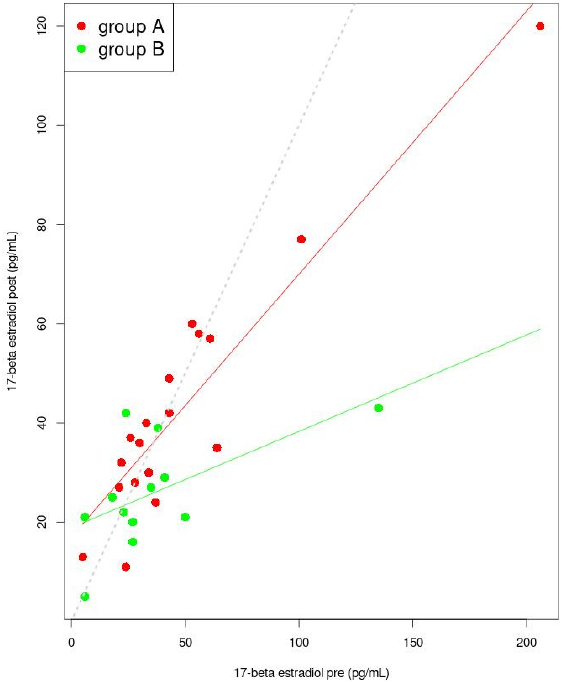
Figure 6. Linear model for 17- β estradiol (post dependence on pre). The lines indicate the predicted trend of changes of “pre” and of “post” values (red for group A and green for group B). The dashed grey line is the set of points for which the pre and post values are identical. Points for group A were marked in red, while points for group B were marked in green.